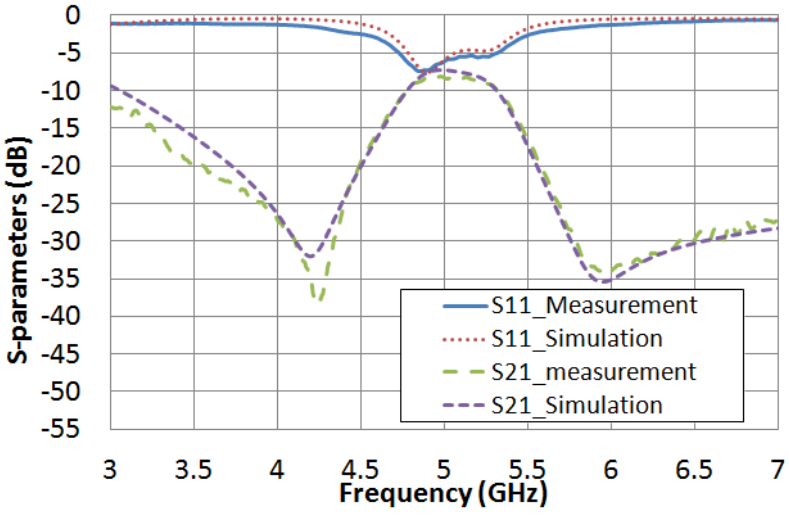
= 2.62 and tan δ = r